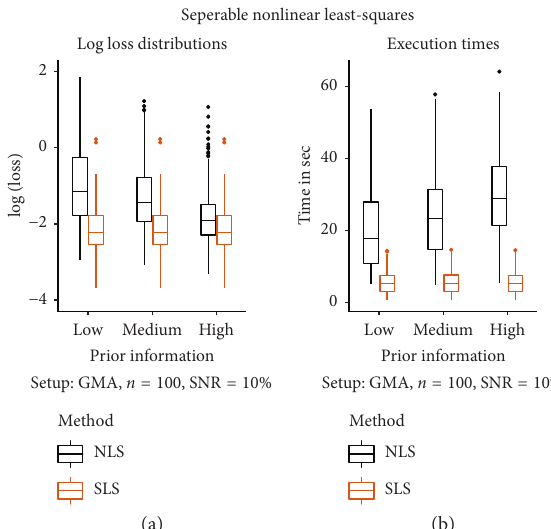
Figure 3: The plot presents a comparison of NLS and SLS. In panel (a) boxplots of the losses (5) and (7) (on a log scale) evaluated at the optimal parameter estimates are displayed. For high-quality prior information, the NLS and SLS loss distributions are close. As the quality of prior information degrades, NLS losses start to assume higher values compared to SLS, and their variability increases, as evidenced by the elongation of boxplots. In panel (b) the com- putation times are compared. The NLS computation times tend to be longer than those of SLS and increase as the quality of prior information increases. In both panels, the performance of SLS does not vary with the quality of prior information, in concordance with the experimental design.